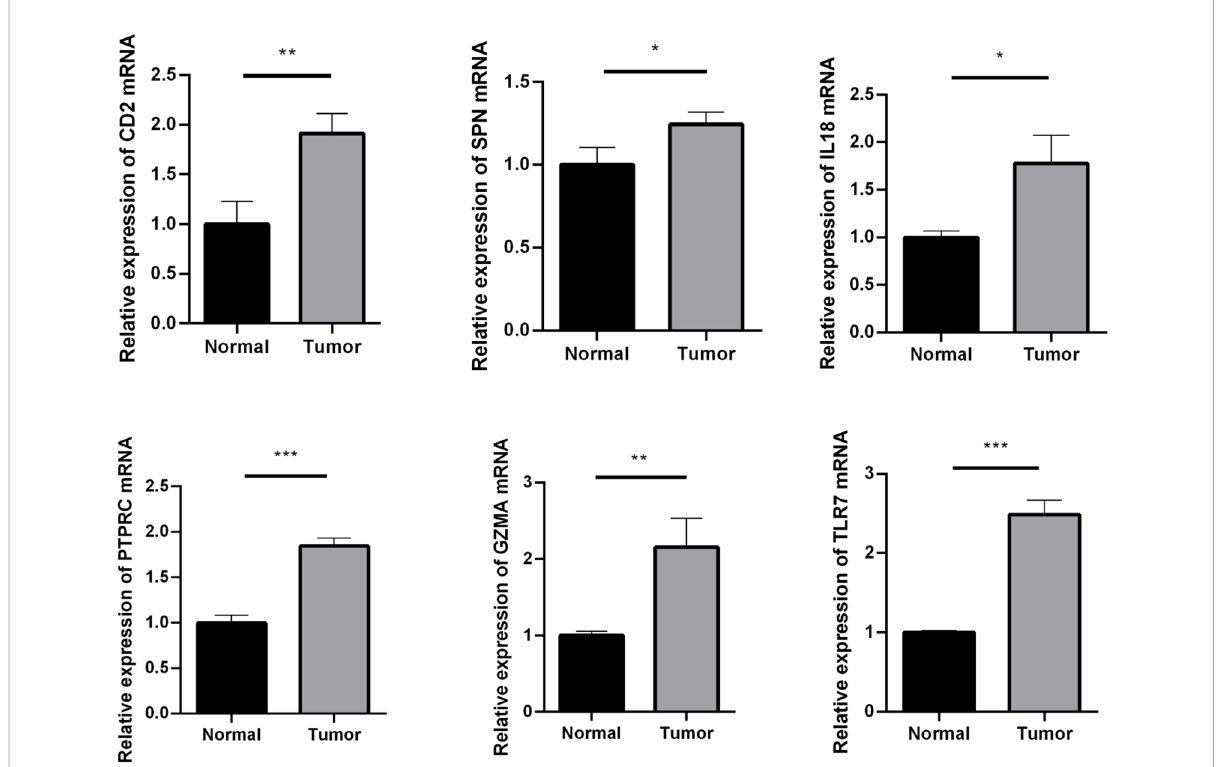
FIGURE 6 RT-qPCR assay used to verify the expression of crucial genes. Compared with the normal group. * p < 0.05; ** p < 0.01; *** p <